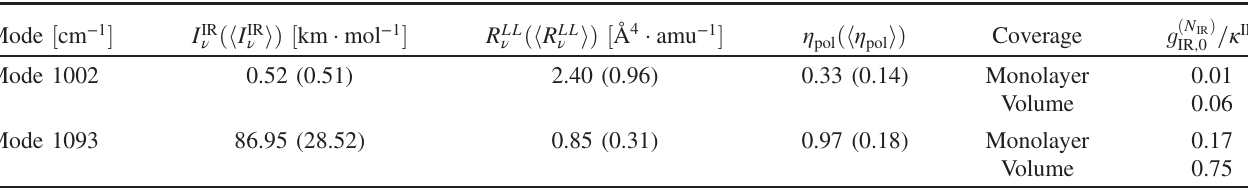
TABLE II. Molecular parameters of interest for our conversion scheme for two vibrational modes of the thiophenol molecule. Calculations are obtained for a molecule oriented vertically with respect to both IR and VIS or NIR local fields (values averaged over all molecular orientations are given in parentheses for completeness). The resulting resonant coupling terms are calculated for two different coverages of the nanostructure by the molecules and given in units of κ IR